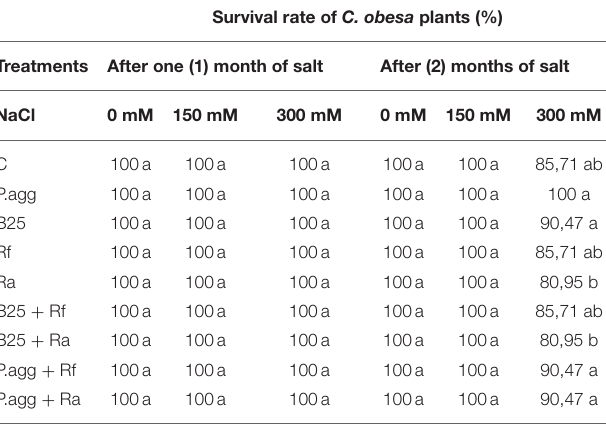
TABLE 1 | Survival rate of C. obesa plants after 1 and 2 months of salt application. Survival rate of C. obesa plants